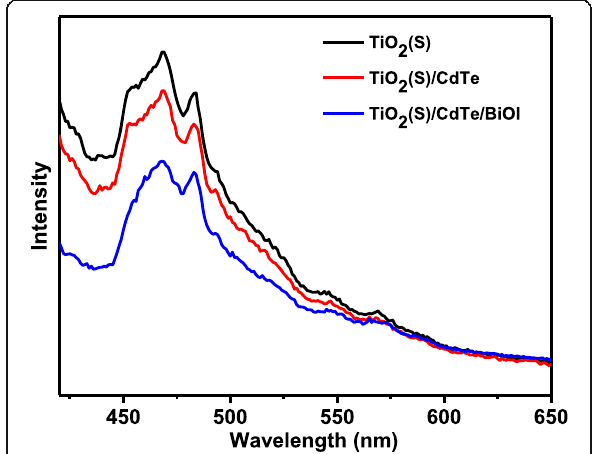
Fig. 9 Photoluminescence spectra of the bare TiO 2 (S), TiO 2 (S)/CdTe/ BiOI, and TiO 2 (H)/CdTe/BiOI samples ( λ excitation = 365 nm)